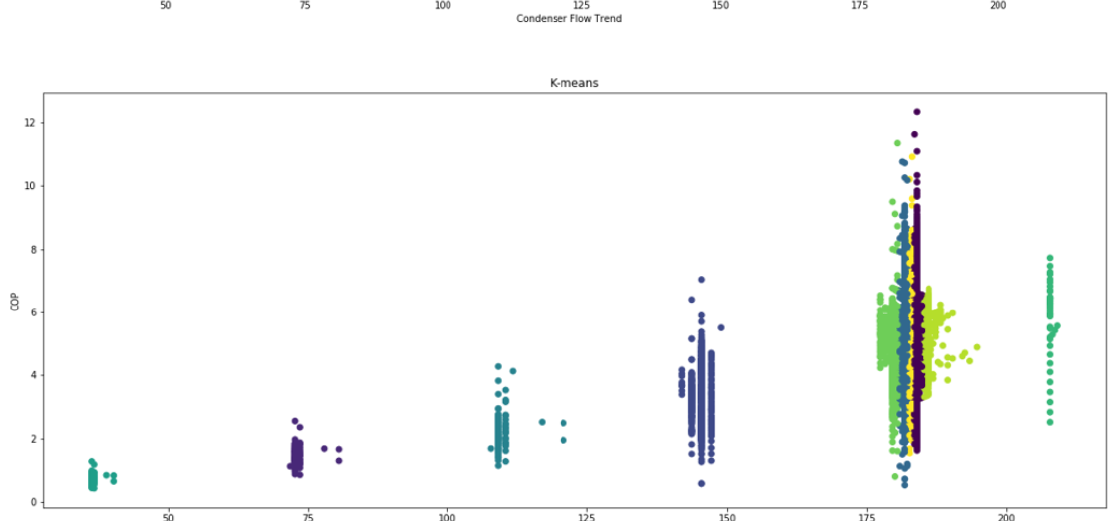
Figure A1. Scatter diagram of the condenser flow trend and COP in different clustering methods. There were five methods validated in this research. The scatter diagram are Mean-shift, OPTICS, Birch, HDBSCAN, and K-means from top to bottom.